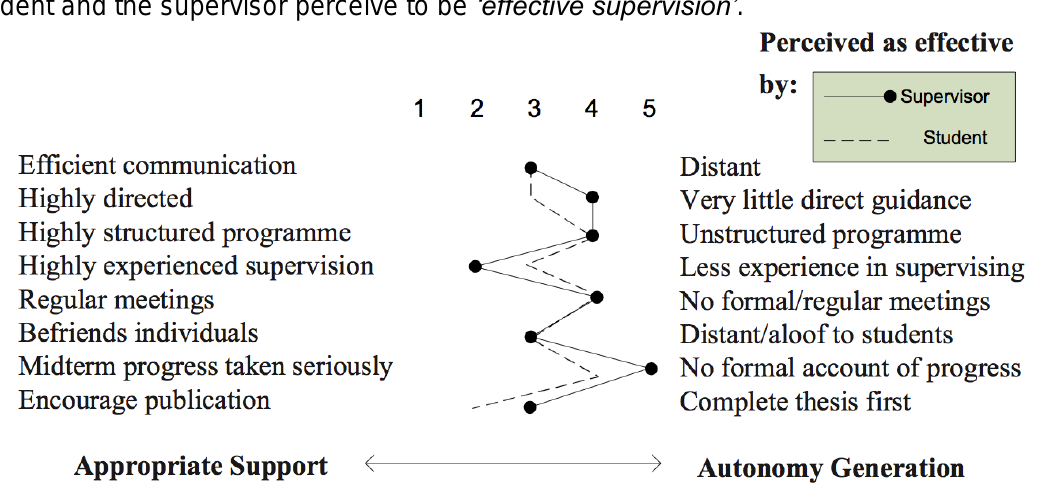
Figure 5 Progress rating (i.e. theory